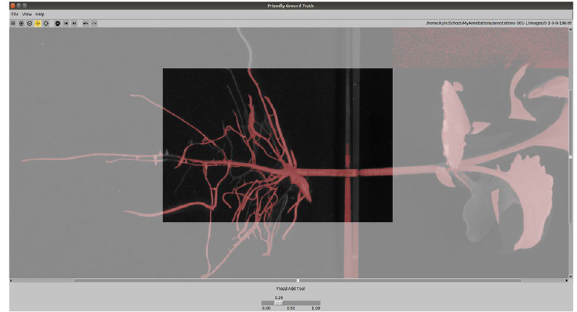
Figure 1. A screenshot of an in-progress annotation on a patch in the Friendly Ground Truth tool. Pixels marked as root are indicated to the user in red. Surrounding patches of the current patch are greyed out and not editable, but provide necessary context for the roots which need to be